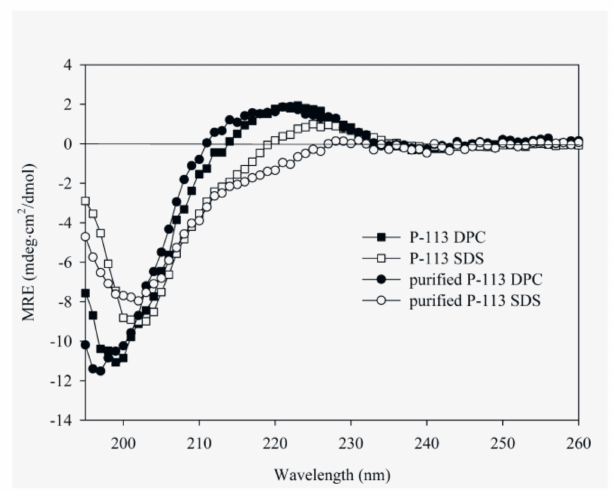
Figure 6. Circular dichroism (CD) spectra of 60 µ M P-113 (chemically synthesized) and purified P-113 (expressed) in 25 mM sodium dodecyl sulfate (SDS) and DPC at 25 ◦ C.